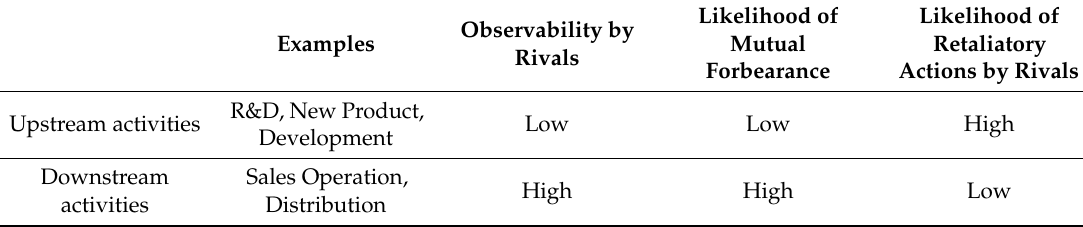
Table 1. Upstream vs Downstream Activities, Observability, and Mutual Forbearance.